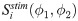
A schematic description of the control strategy.An array of neuronal patches (white circles) is controlled using M = 2 microelectrodes (red-blue cones). The signals, KRsin(Ψ − ϕi), i = 1, 2, acquired by each microelectrode are passed (red arrows) to the controller that computes the control signals, Sistim(ϕ1,ϕ2), i = 1, 2, which are in turn (blue arrows) injected back to the neuronal patches 1 and 2. This determines an electromagnetic field which possesses a spatial extension whose strength decays with the distance from the injection point (large circles with shaded of blue). In this way nearby neuronal patches are also influenced but in a weaker fashion. The mechanism is presented as a sequence of steps repeated cyclically (external grey circular arrows), however under the assumption that the measurement and the computation of the control and the injection are very fast with respect to the natural time scale of the underlying system, this process can be considered to be instantaneous and thus acting directly on the evolution of the system without any delay (see Eq (14)).